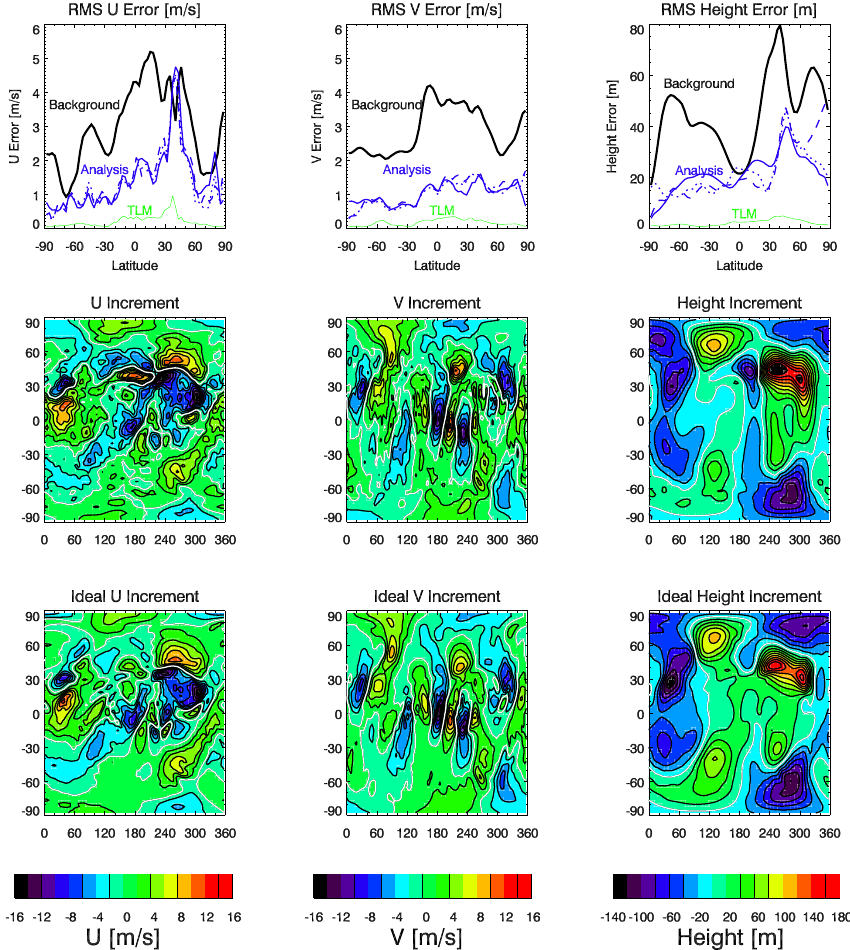
Fig. 3. Top row panels: RMSE for zonal wind, meridional wind, and height as a function of latitude for the first cycle of O 3 assimilation from the BEST experiment. Black lines show the background errors at t =0h. Blue lines show analysis errors at t =0h (solid), 3h (dotted), and 6h (dashed). Green lines show the TLM errors after 6h of integration. Middle row panels: the analysis increments as a function of longitude and latitude at t =0h. Bottom row panels: the ideal increments as a function of longitude and latitude at t =0h. For the increment maps, red (blue) contours indicate high (low) values. Units are ms − 1 for zonal and meridional wind and m for